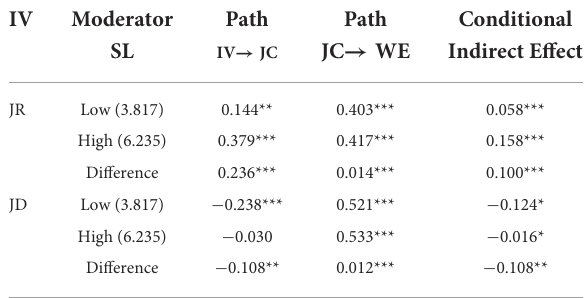
TABLE 6 Moderated mediation effect